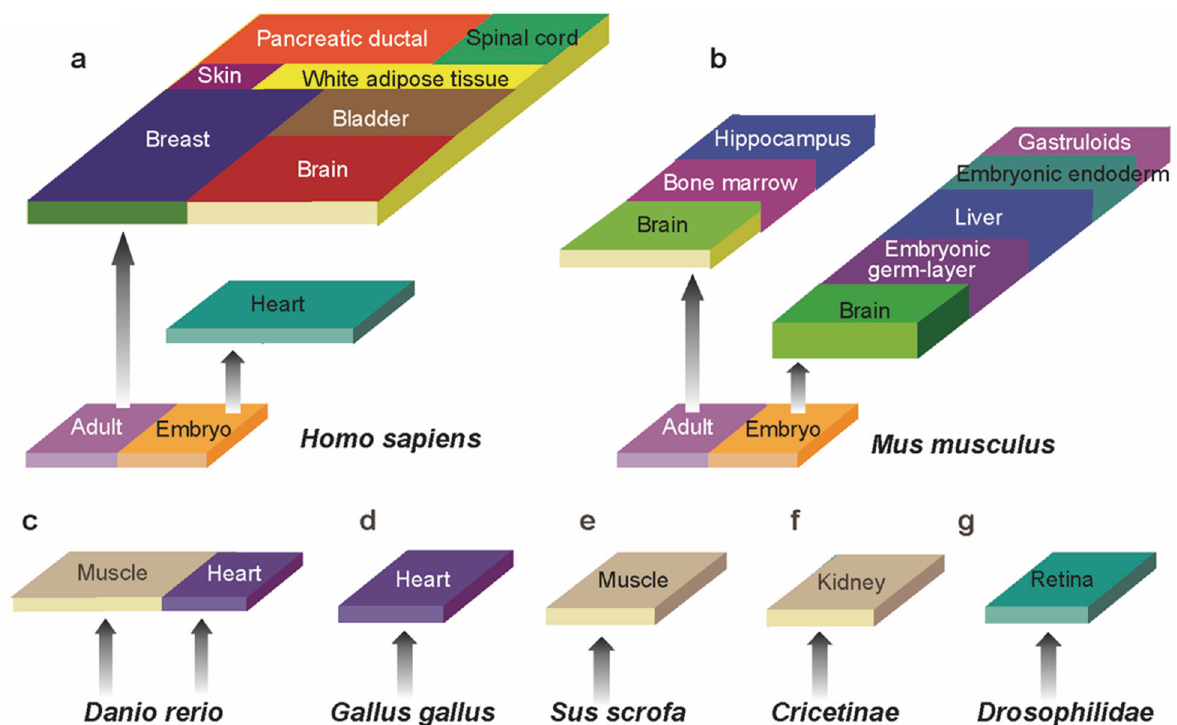
Fig. 3 Representative spatial transcriptomics studies across multiple species. a Representative ST studies in tissues of Homo sapiens ; b Representative ST studies in tissues of Mus musculus ; c Representative ST studies in tissues of Danio rerio ; d Representative ST studies in tissues of Gallus gallus ; e Representative ST studies in tissues of Sus scrofa ; f Representative ST studies in tissues of Cricetinae ; g Representative ST studies in tissues of ST in neurology The neural system ST provides new insights into understanding individual neuron types, locations, dendritic structures, axon projections, and corresponding functions. 92 ST pro fi les of dysfunc- tional brains offer molecular information on developmental or degenerative organization and location of brain cell types, to develop new molecular biomarkers/targets and to understand new mechanisms of brain diseases. 93 Paralysis in amyotrophic lateral sclerosis (ALS) is caused by denervation of skeletal muscle, degeneration of motor neurons, dysfunctional interaction between motor neurons and glial cells, and loss of motor neurons. 94 Using Fiji “ Analyze particles ” plugin and ST pipeline for data processing, ST with a hierarchical generative probabilistic model was used to measure gene expressions of mouse spinal cords and postmortem tissues of patients with ALS, distinguish regional differences between early microglia and astrocytes, and to identify interferences of transcription pathways between ALS model and patient spinal cord pathology, 95 as explained in Fig. 4a. Spatial distributions of about 11,138 genes were uncovered in mice dynamically after the induction of ALS and further 9624 genes spinal cord samples were uncovered from patients with ALS. This particular study de fi ned the clear positioning and multi- dimensional distributions of gene expressions in tissue and described new mechanisms of the degenerative disease, e.g., TREM2-TYROBP complex, Apoe , Lpl , B2m , and Cx3cr1 at different stages and positions. 95 The 16 dysregulated transcripts in 6 disease-related pathways were found from ST pro fi les of post mortem brain tissue using ST pipeline for data processing. Of those, the metabotropic glutamate receptor 3 and ubiquitin speci fi c protease 47 were furthermore identi fi ed with comple- mentary molecular pathology as spatial disease-speci fi c targets. 96 The dysregulation of glutamate neurotransmission and synaptic plasticity by the metabotropic glutamate receptor 3 and cell